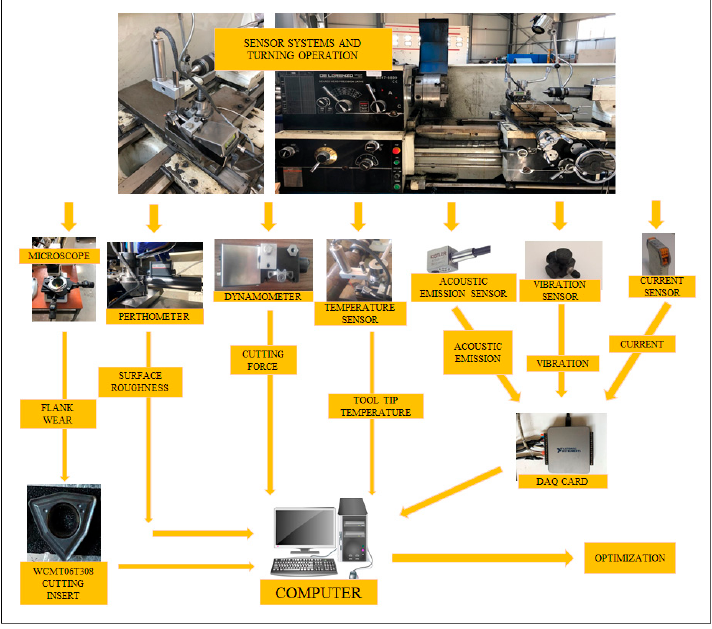
Figure 1. Experimental setup for turning.